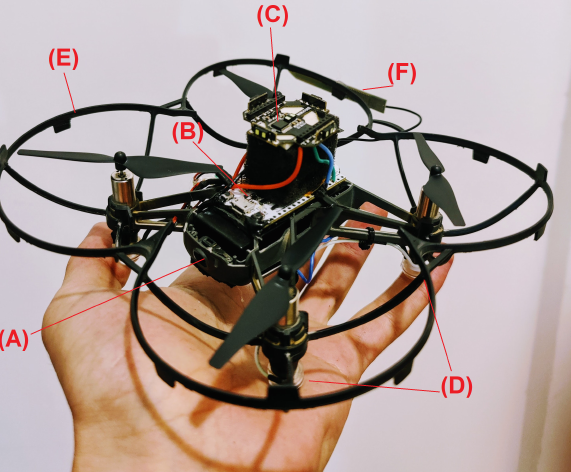
Figure 1. Our Blind Autonomous Tiny-drone (BAT), which is based on the Tello commercial tiny- drone (A). BAT is equipped with a multi ranger LIDAR array (front, left, right, up, and back) marked by (C), and it uses a WiFi based microcontroller (B) to control the Tello as if it was a remote control. Prop guards are used to protect BAT (E), 4x down facing LEDs are used for low light conditions (D), a small LoRa (UHF) antenna (F) is used to transmit mapping data to the mapping